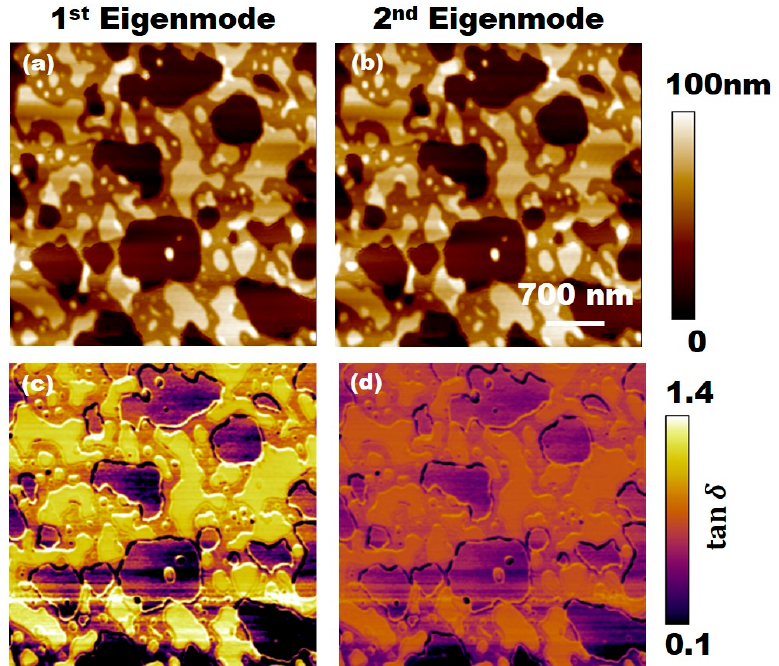
Figure 4. PS loss tangent AFM images: ( a ) topography image using the 1st eigenmode, ( b ) topography image done with 2nd eigenmode, ( c ) tan δ image using the 1st eigenmode, and ( d ) tan δ image using the 2nd eigenmode. The scale bar is 700 nm. The free oscillation amplitude of the first and second eigenmode were 100 nm and 20 nm, respectively. The setpoint for both measurements were 60% and done in repulsive regime. The first and second excitation frequencies were 70 kHz and 460 kHz, respectively.